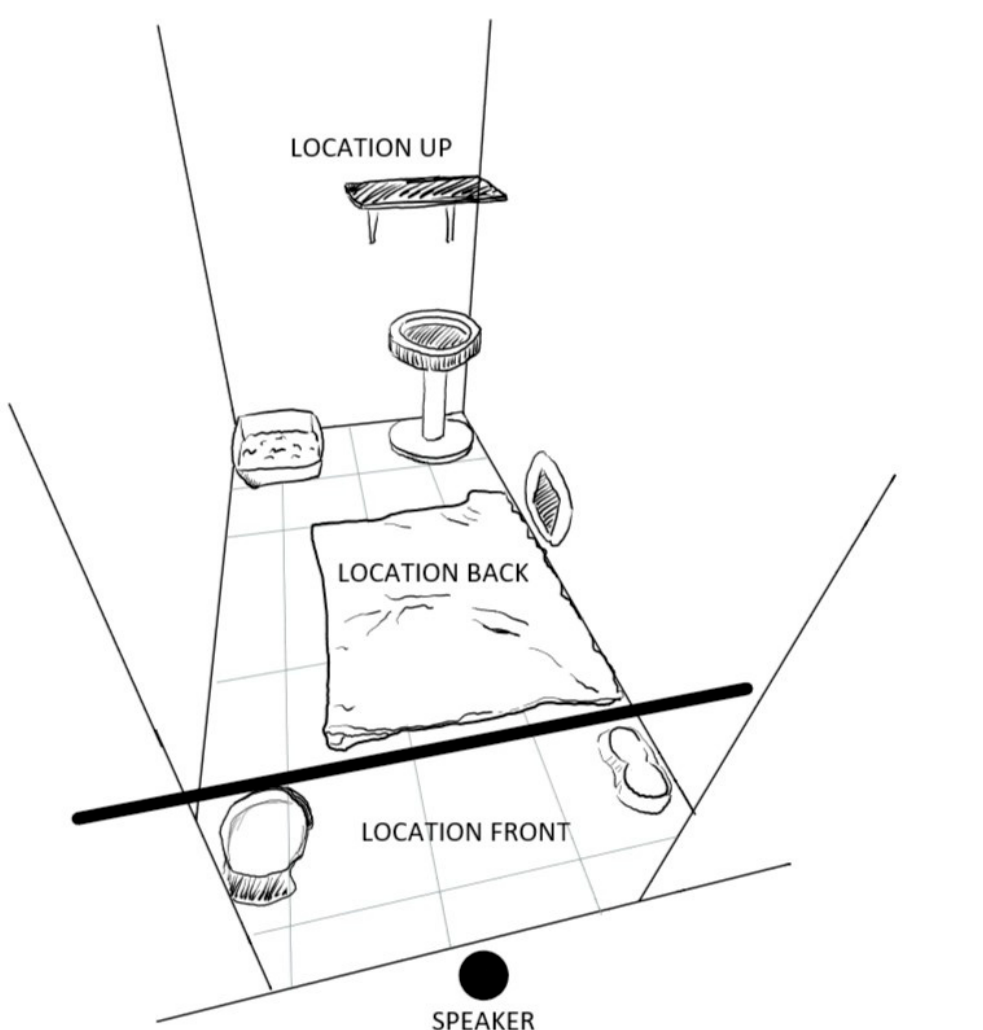
Figure 2. Representation of the cats’ enclosure with the different sections (chair and hammock not depicted in order not to obstruct the view). In the P+ condition, the reader was always sitting left from the speaker facing sideways visible to the cats but not obscuring the front door and the camera’s field of view.